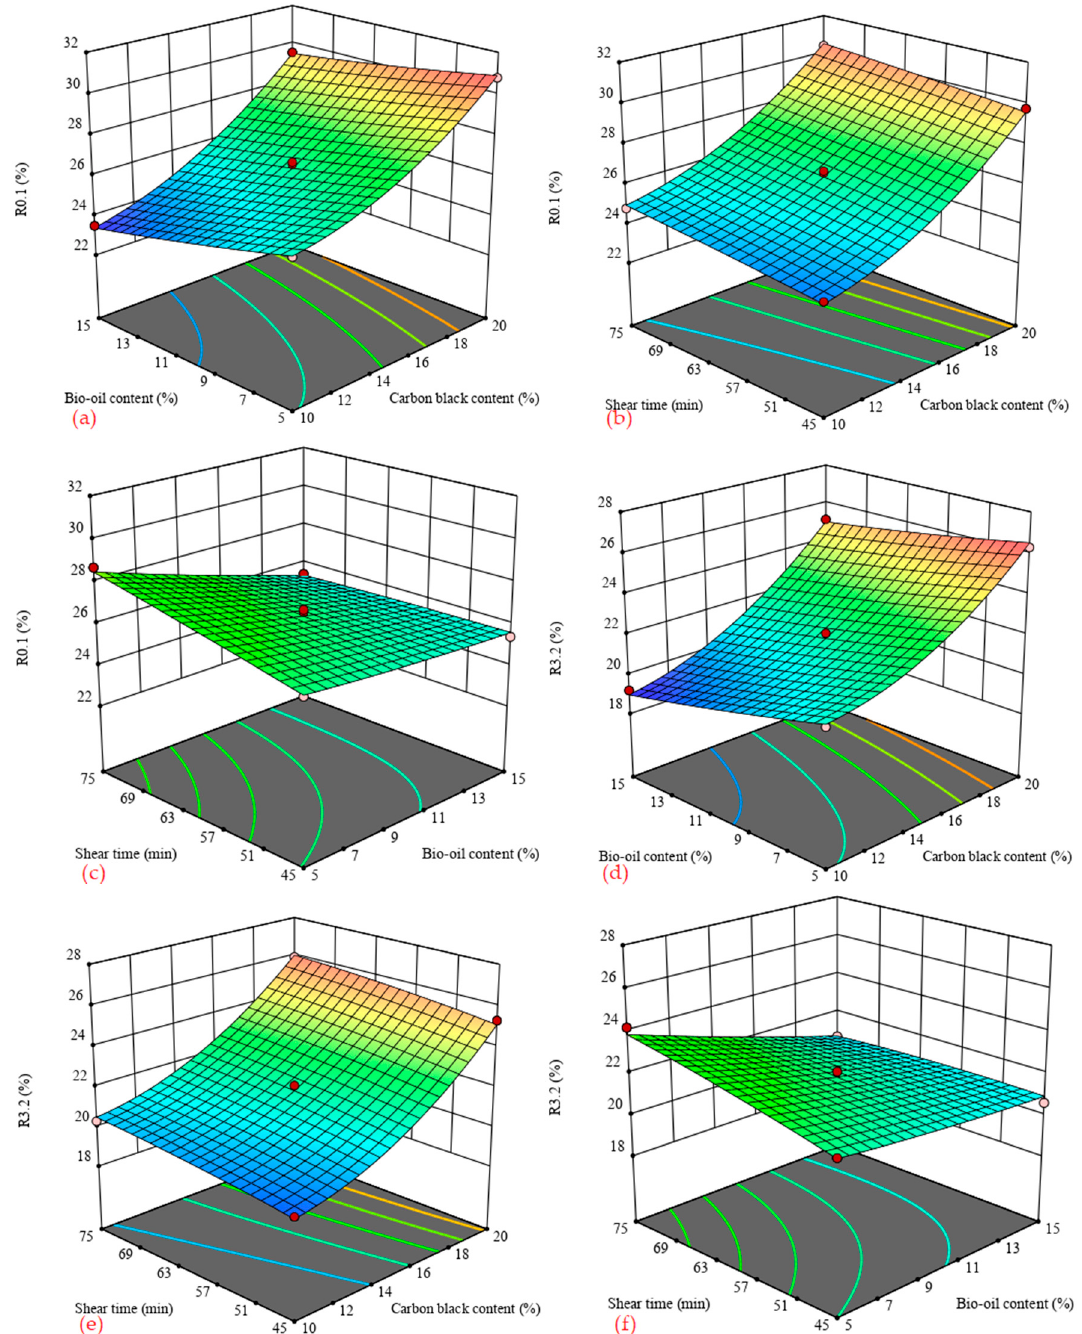
Figure 5. 3D surface of R value with influence factors. ( a ) shear time = 60 min; ( b ) bio-oil content = 10%; ( c ) carbon black content = 15%; ( d ) shear time = 60 min; ( e ) bio-oil content = 10%; ( f ) carbon black content = 15%.